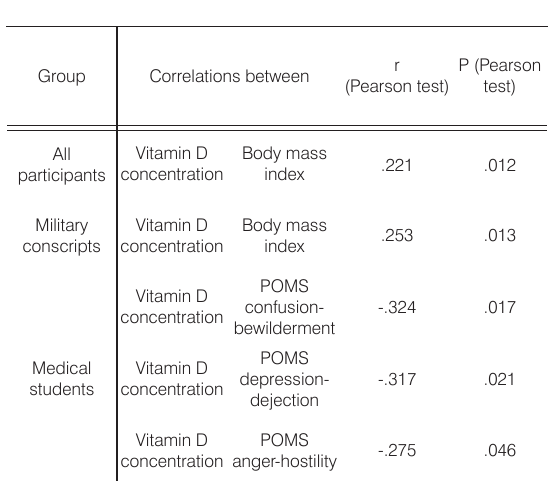
Table 9 Significant correlations between vitamin D concentration and parameters of body composition or psychological state